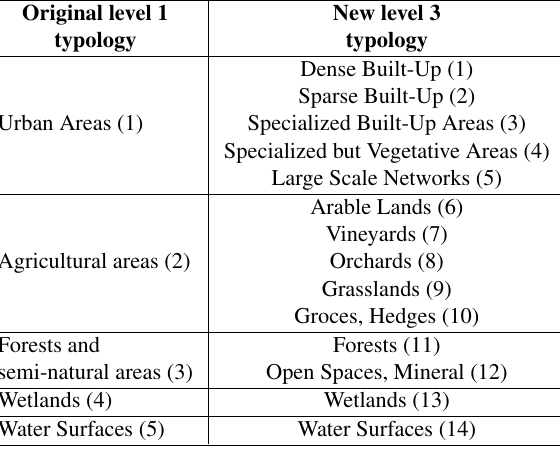
Table 1. Class name and pixel value in the final reference data in a raster format.